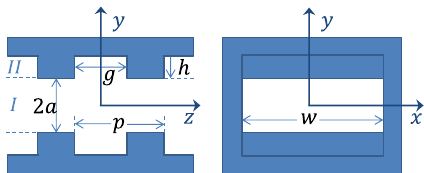
FIG. 9. Geometry of dechirper parameters: longitudinal cut with two periods (left) and transverse cut (right).